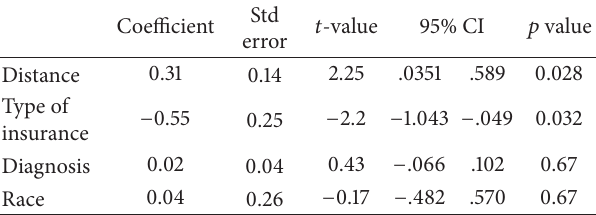
Table 4: Multivariable least square regression analysis exploring the association between duration of symptoms and type of insurance, distance from our hospital, referral diagnosis, and